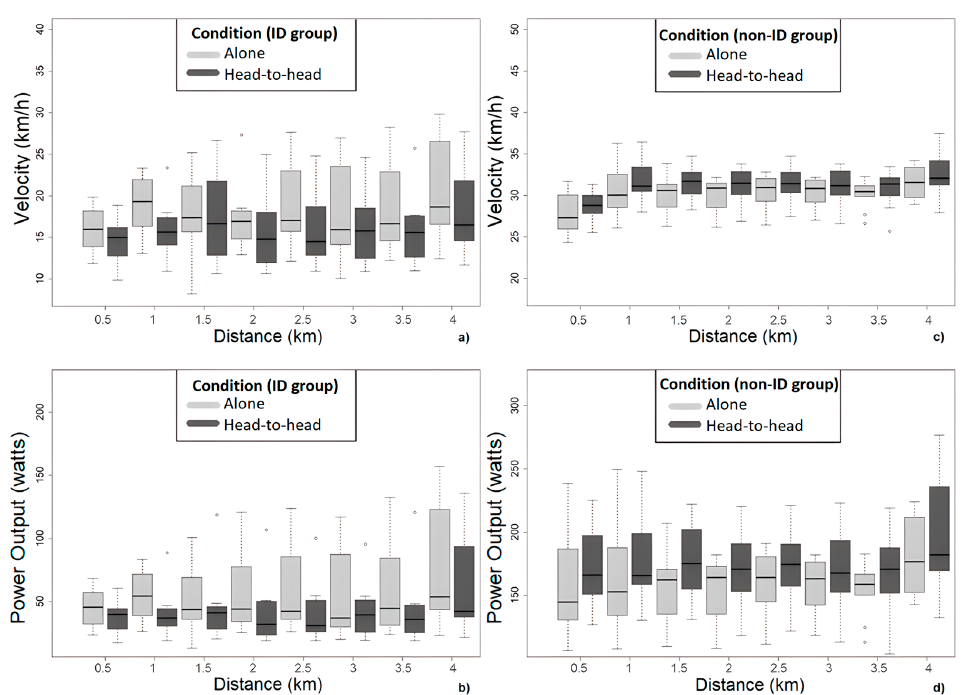
Figure 3. Box plots with the velocity and power output differences per condition (‘alone’ and ‘head-to-head’) for the ID ( a , b ) and the non-ID groups ( c , d ) at different distance points (° = outliers).